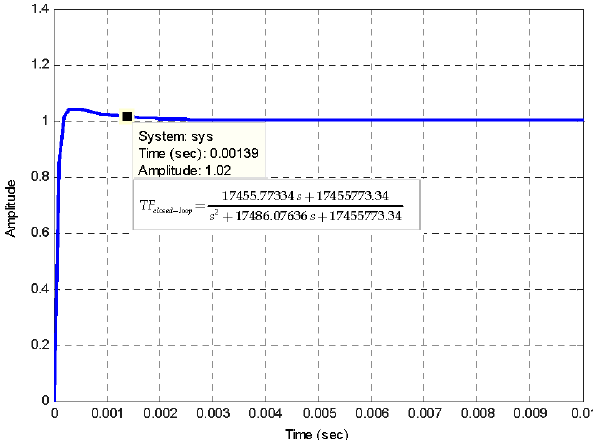
Figure 7. Parametrized block-diagram of the gyroscopic model system (sinusoidal bias phase-modulation and serrodyne feedback phase-modulation. Initial parameters: P d = 145.61 μ W, L = 300 m, D = 0.08 m, λ = 1310 nm and R = 0.69 μ A/ μ W.